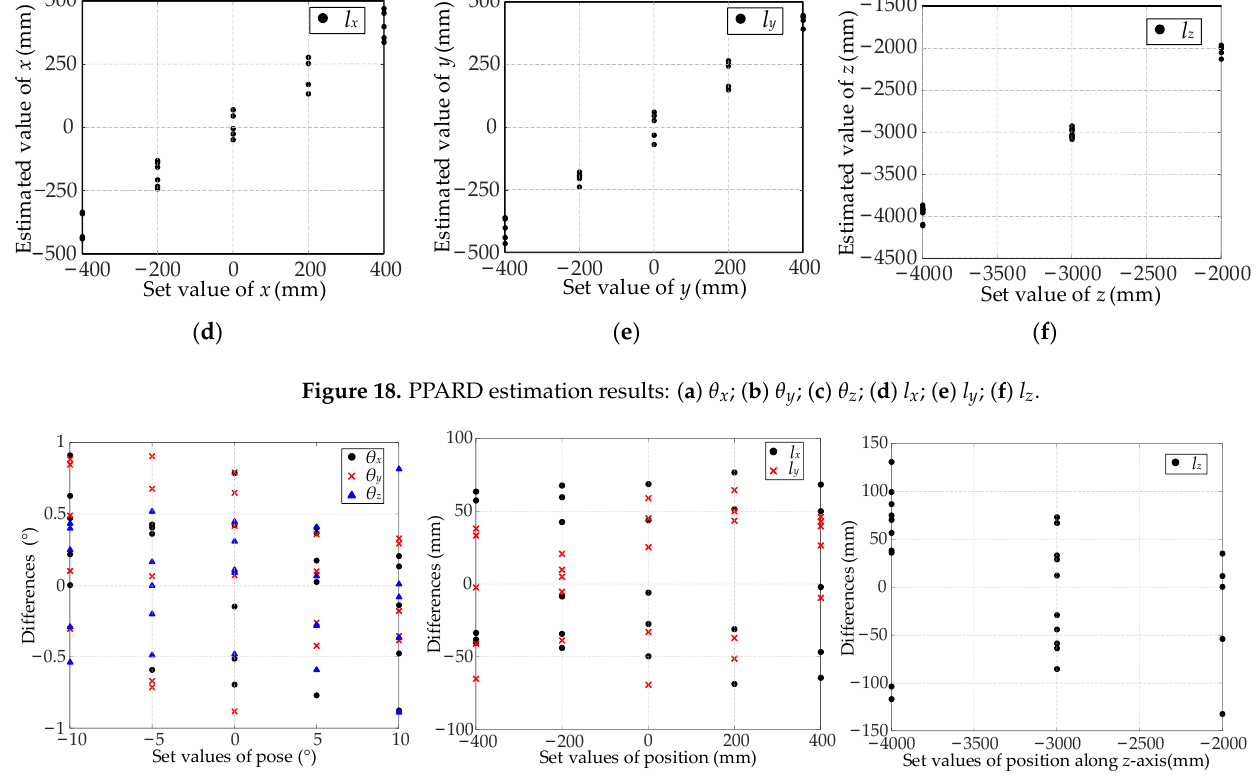
Figure 19. Differences in the estimated and set values: ( a ) three rotation angles; ( b ) l x and l y ; ( c ) l z . It shows that, for any DOF, the errors under different positions or poses setting val- ues were relatively close. The estimation error for the rotation angles of the three axes was less than 1° and the relative error was less than 10%. The estimation error of the positions in the x - and y - directions was less than 80 mm, and the relative error was less than 10%. The estimation error of the positions in the z -direction was less than 140 mm and the rel- ative error was less than 3.5%. To further evaluate the accuracy of the PPARD estimation, the evaluation methods proposed for rotation error E rot and translation error E trans in [24] were used. () = = 3 1 m a x a r cc o s kk r o tt r u e k E k r are the k -th columns of the true value R true and the estimated value R of the rotation matrix; t and t ture are the estimated and true values of the translation matrix, respectively. Using these two indicators to evaluate the accuracy of the PPARD estimation algorithm, the results are shown in Figure 20. In the experiment, the distance between the camera and guidance lamps along the z -direction was 4000 mm for experiments 1 – 10, 3000 mm for experiments 11 – 20, and 2000 mm for experiments 21 – 25. From the results, it can be seen that the rotation error was less than 1.3°. The general trend was that the rotation error decreased with a decrease in the distance between the camera and guidance lamps along the z -axis. The translation error was less than 12%. ( a )